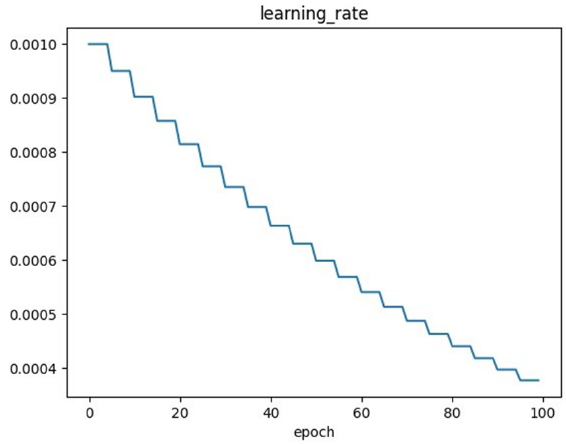
Figure 5. Decay of the learning rate in model training.